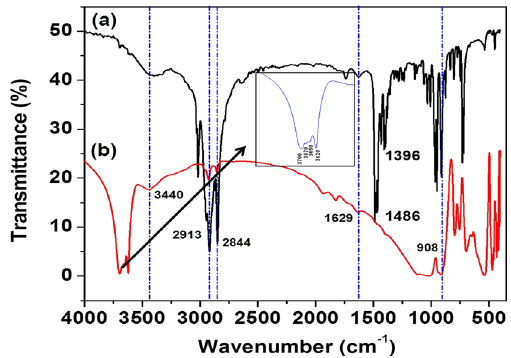
Fig. 2 FTIR spectra of a CTAB and b kaolin–CTAB